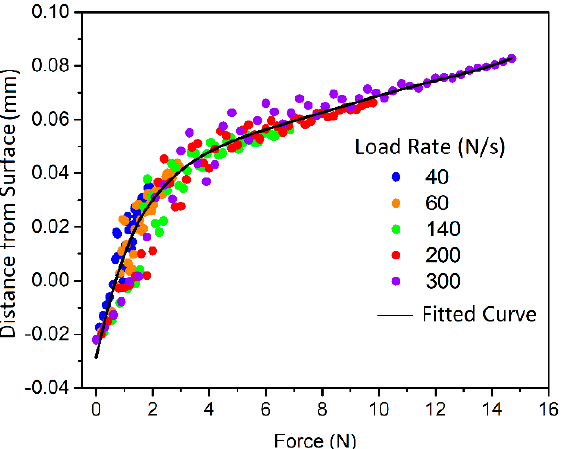
Figure 6. Force and indentation depth at different force-loading rates for rough surface.